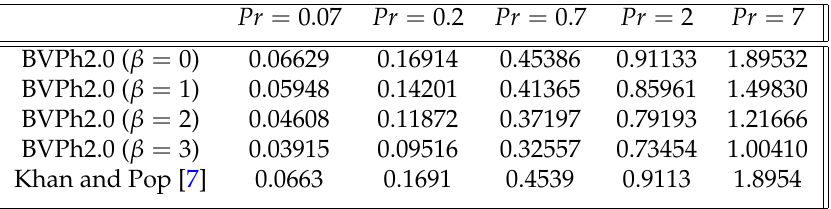
with λ → ∞ and N = 0. ∂η η = 0